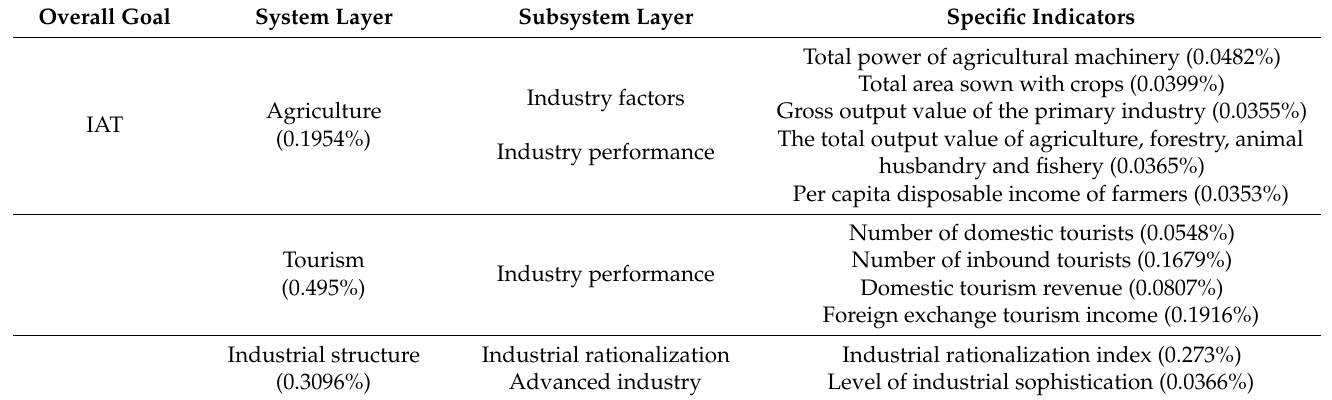
Table 2. Comprehensive index system of